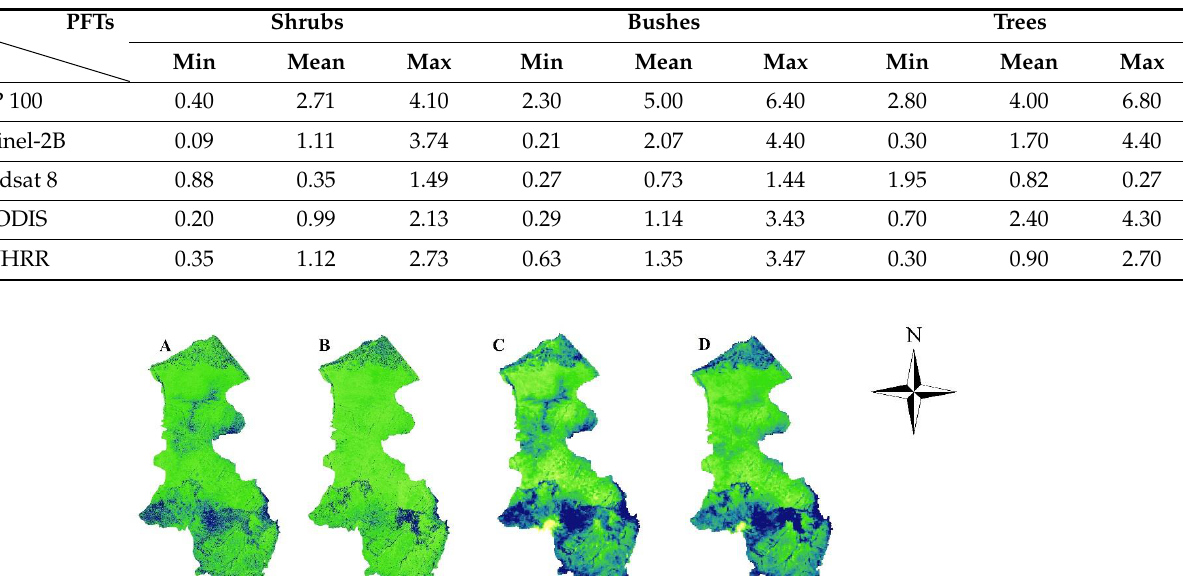
Table 4. Descriptive statistics of estimated LAI using LP 100 and different sensors extracted for sampling points in different PFTs.